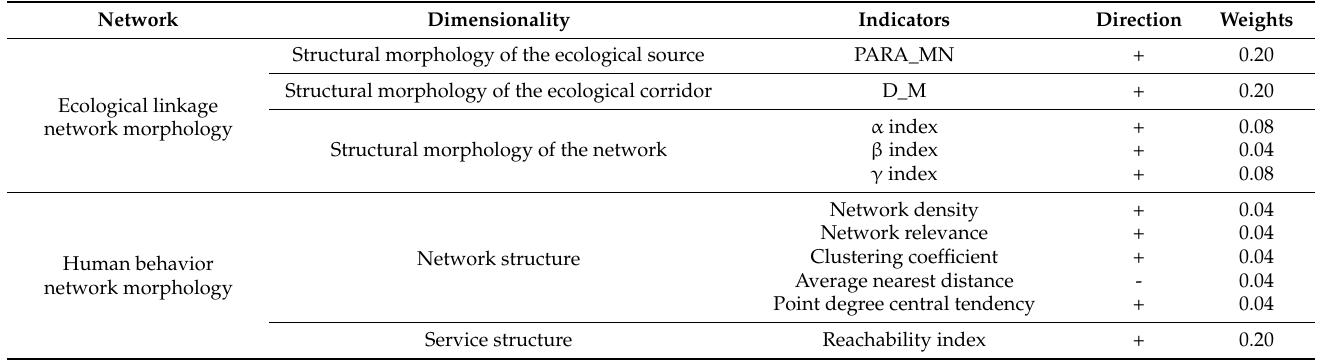
Table 2. Spatial morphology optimization evaluation index system of rural